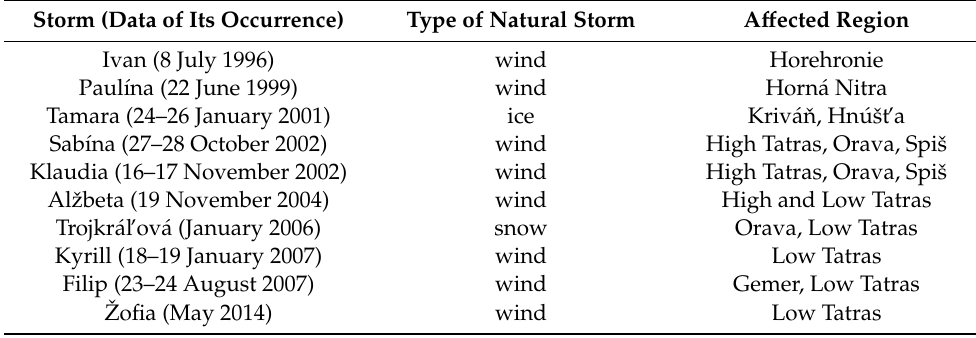
Table 3. Overview of significant windstorms (disasters) of northern and central Slovakia. Storm (Data of Its Occurrence)